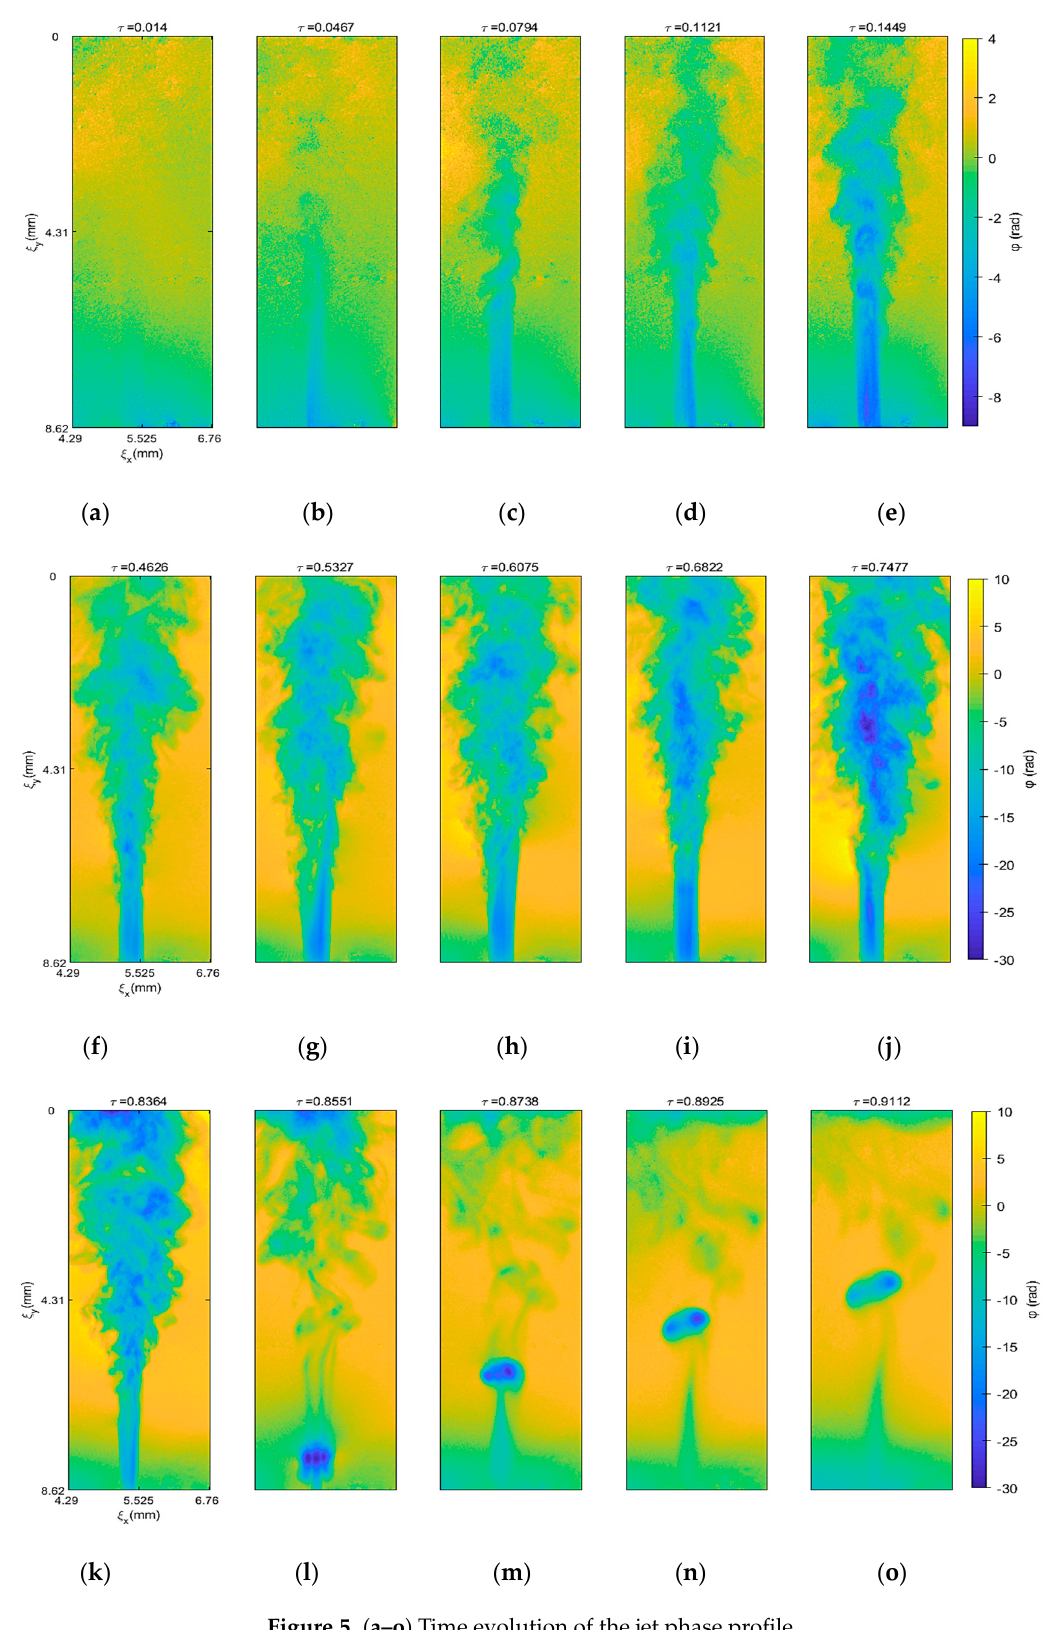
Figure 5. ( a–o ) Time evolution of the jet phase profile.